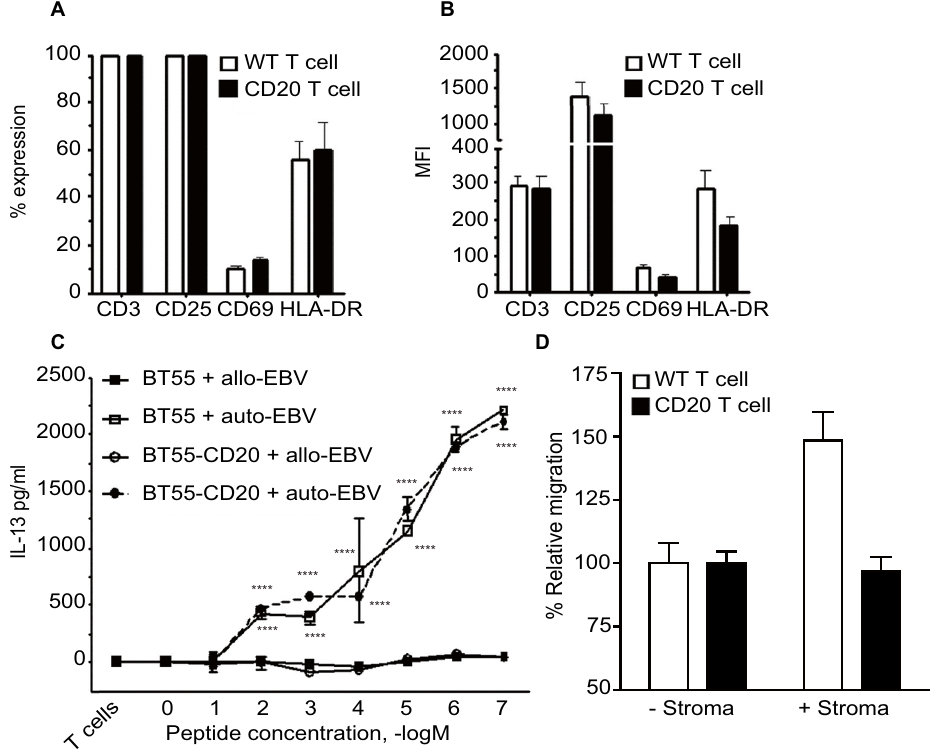
Figure 4. Ectopic expression of CD20 on T cells associates with altered transmigration and adhesive properties but does not alter phenotype or response to TCR/antigen stimulation. T cells were transduced with the CD20- encoding retroviral vectors (mean transduction efficiency of 50%). ( A ) CD20- and CD20 + T cells were gated and the percentage CD3, CD25, CD69 and HLA-DR and ( B ) the mean fluorescence intensity (MFI) was determined. The bars represent the mean ± SD of three independent experiments. ( C ) The cow milk peptide (CMP) CD4 + T cell clone (BT55) was transduced with the CD20-encoding retroviral vector and subsequently purified. Different concentrations of CMP (100 μg–0.001 μg) were loaded on autologous and allogeneic EBV-B cells and presented to the transduced and the non-transduced cells. IL-13 production was measured upon stimulation of the BT55 clone with increasing concentrations of CMP. The mean ± SD of three independent experiments are shown. A 2way ANOVA was performed to determine significance. ( D ) For the migration assay HS-5 stromal cells were seeded in a 24-wells plate and after 24 h of incubation at 37 °C, T cells with or without CD20 were added onto a transwell system (5 μm pore size). These transwell systems were placed into 24-wells plate containing the stromal cells or as a control the medium. After 24 h the percentage of the migrated cells was determined by FACS